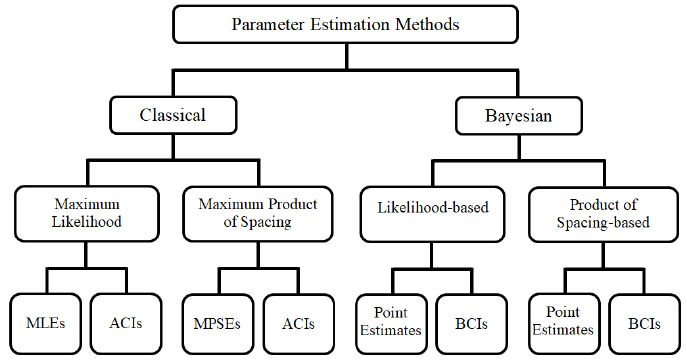
Figure 1. Flowchart of the proposed estimation